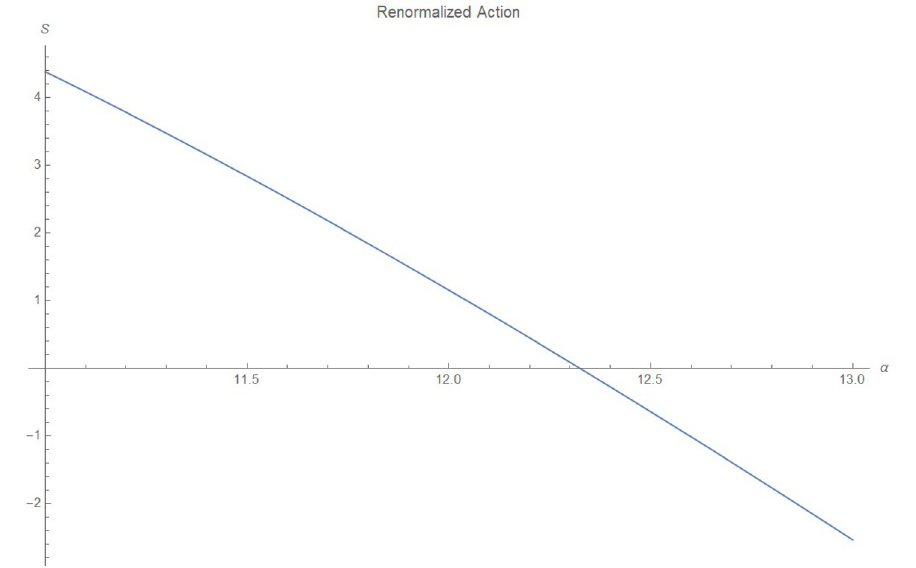
plotted as a function of the scaling parameter α Figure 1 . The action S diff on − shell